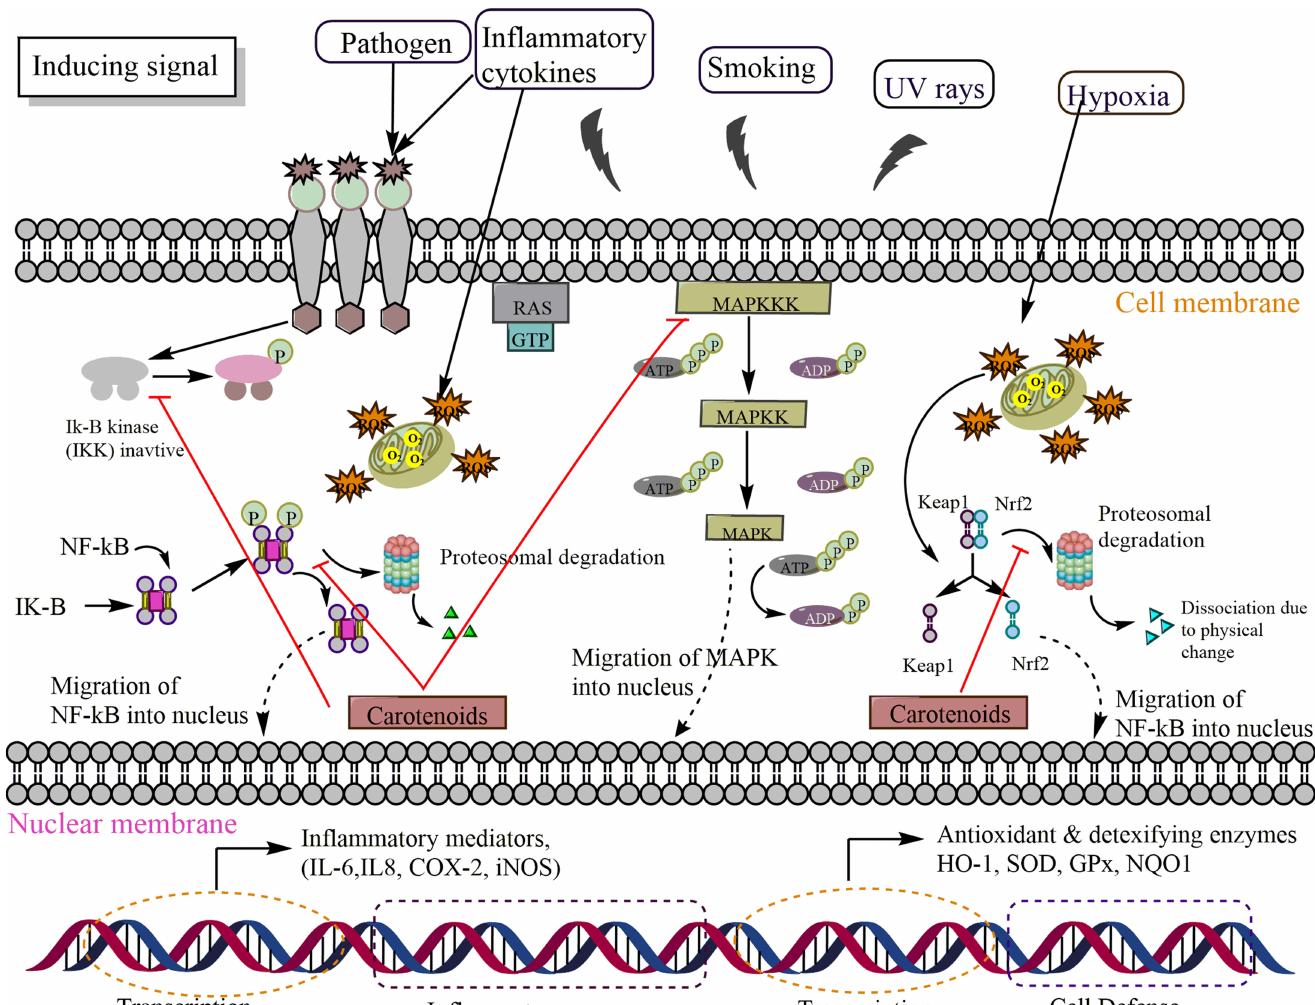
Figure 4. Anti-inflammatory effect of carotenoids on different inflammatory signaling pathways (Adapted from Ref.